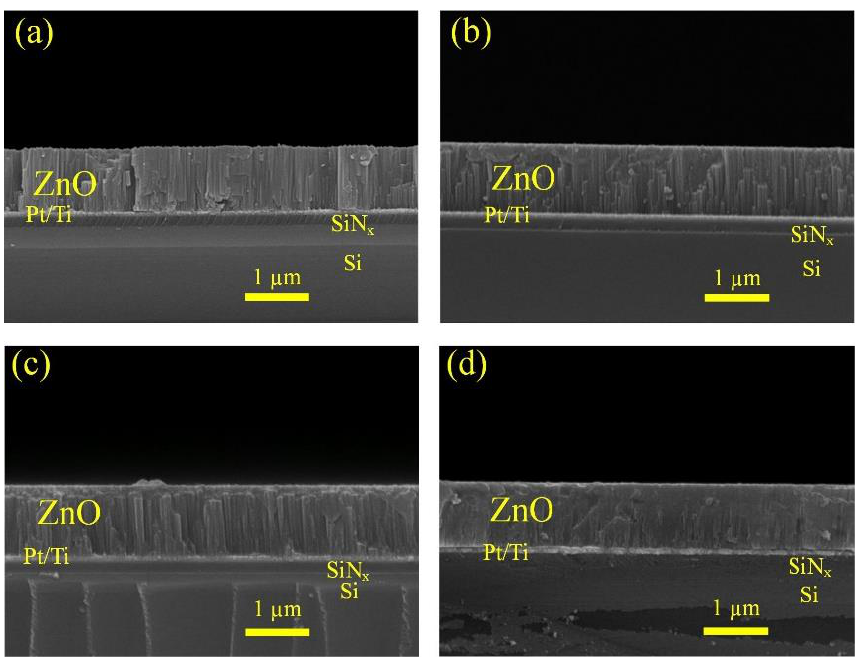
Figure 5. The cross-sectional images of as-deposited ( a ) and RTA treated (( b ) 300 °C, ( c ) 400 °C and ( d ) 500 °C) ZnO thin films for 10 min.